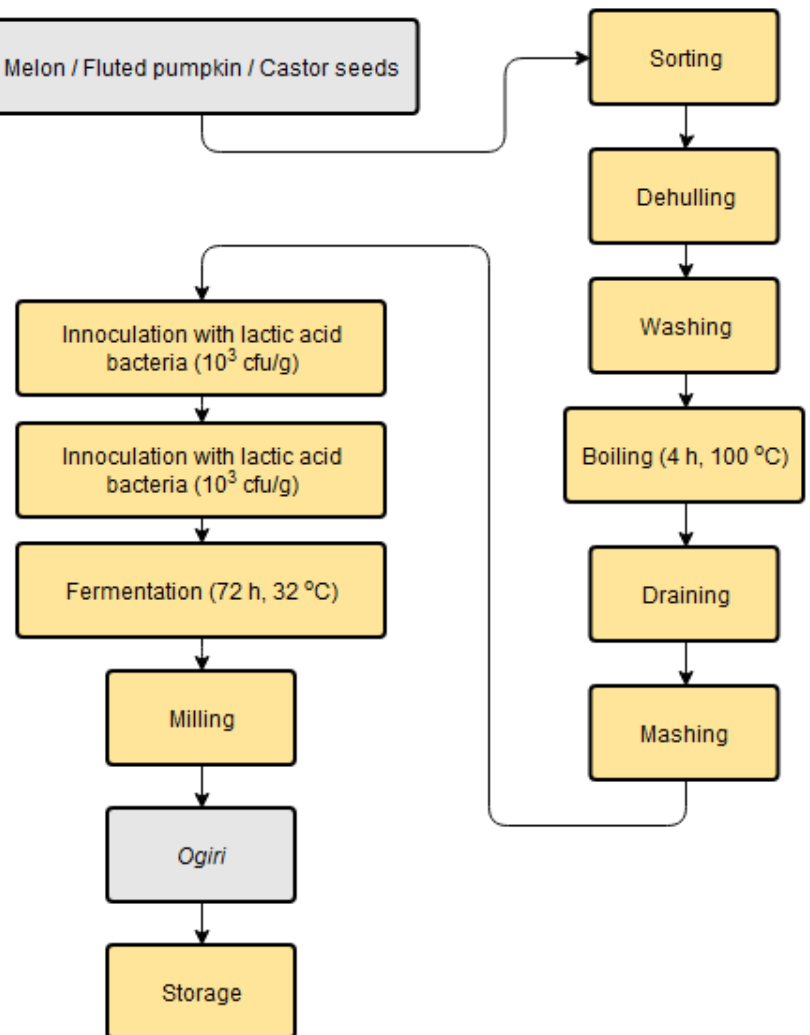
Figure 2. Flow chart for preparation of Ogiri from different vegetable